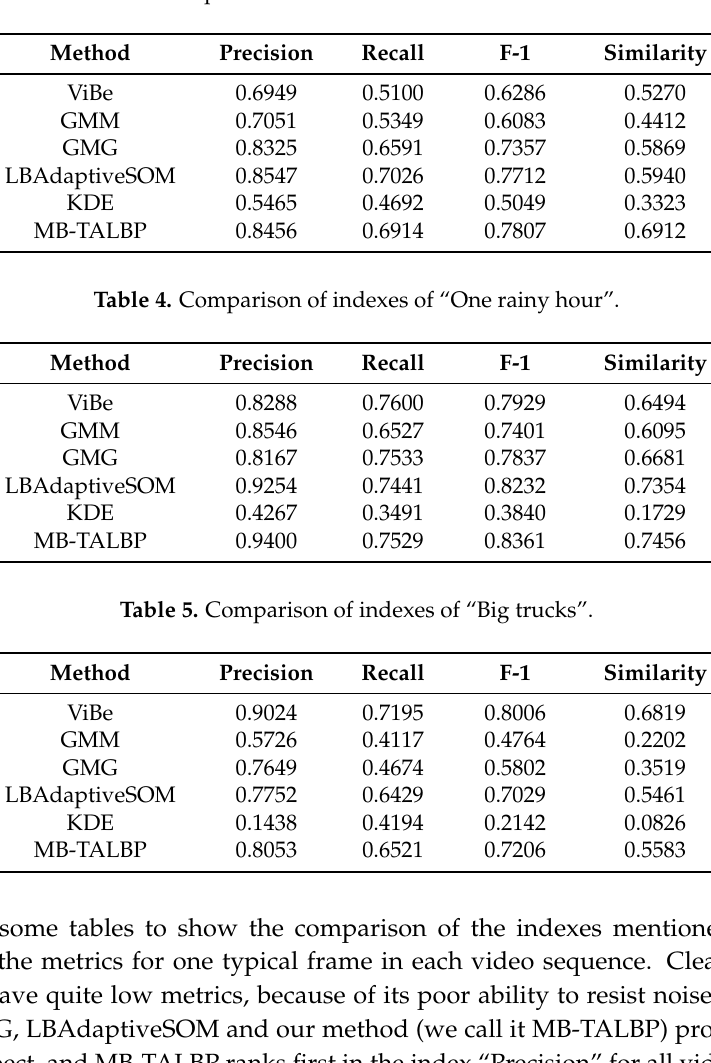
Table 3. Comparison of indexes of “Beware of the trains”.